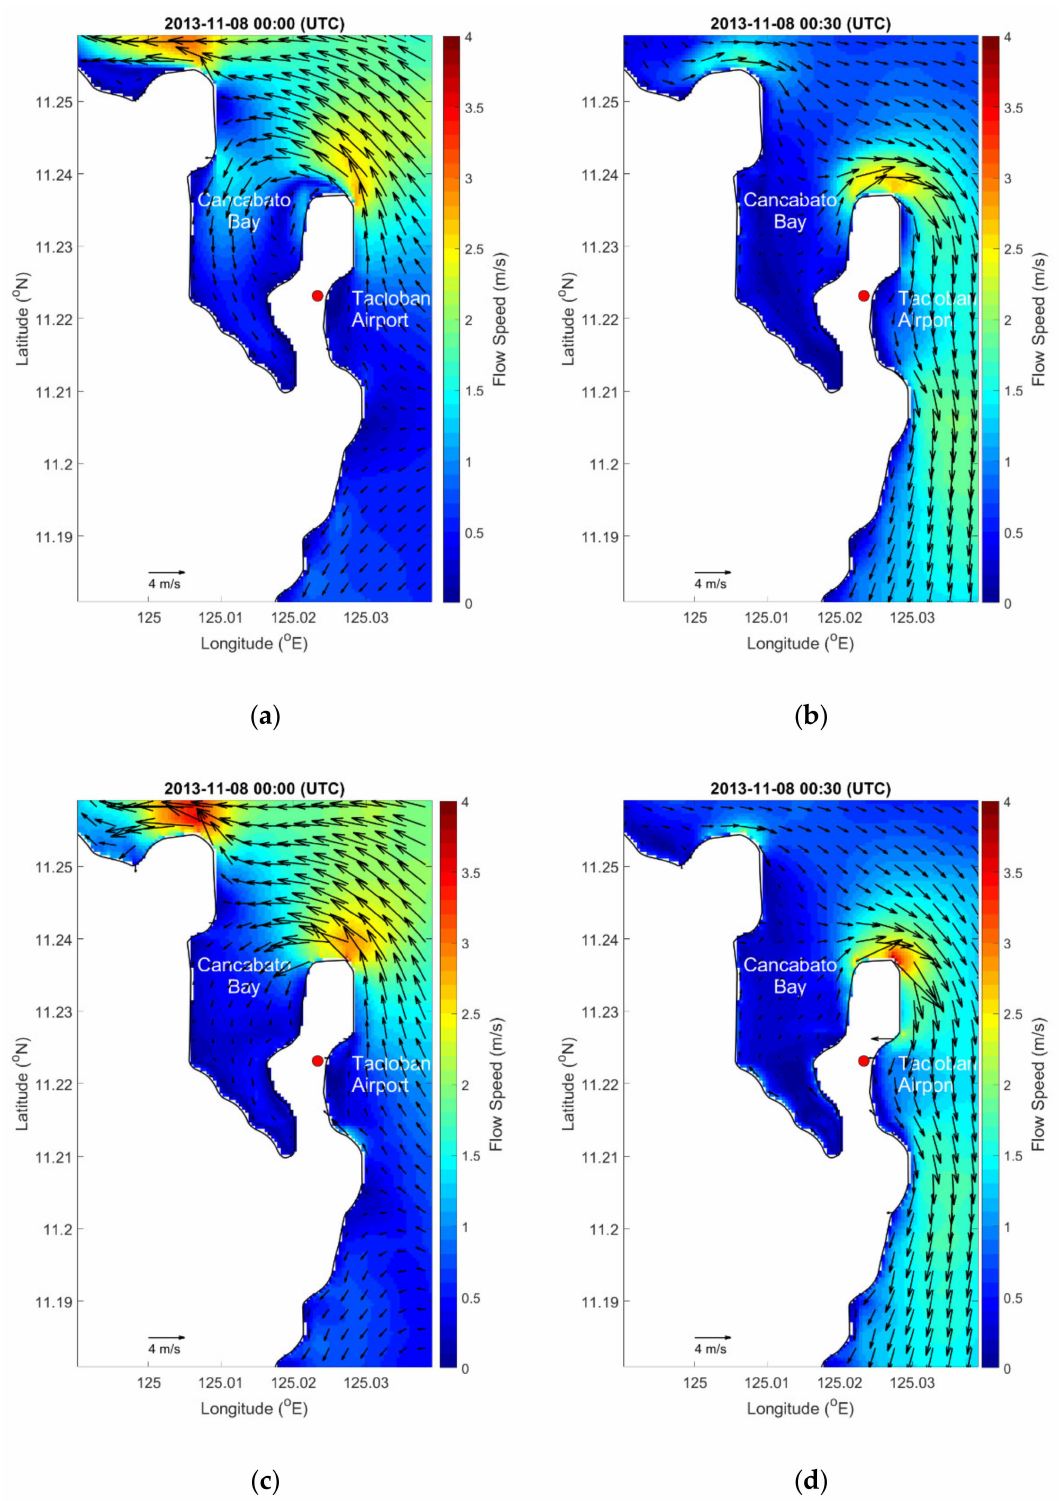
Figure 16. Storm-induced current fields by the nonlinear equation model with the fixed shoreline at ( a ) 00:00 UTC on 8 November 2013 and ( b ) 00:30 UTC on 8 November 2013. Storm-induced current fields by the linear equation model with the fixed shoreline at ( c ) 00:00 UTC on 8 November 2013 and ( d ) 00:30 UTC on 8 November 2013. The color shading indicates the flow speed in m/s. The black arrows show the flow velocities in